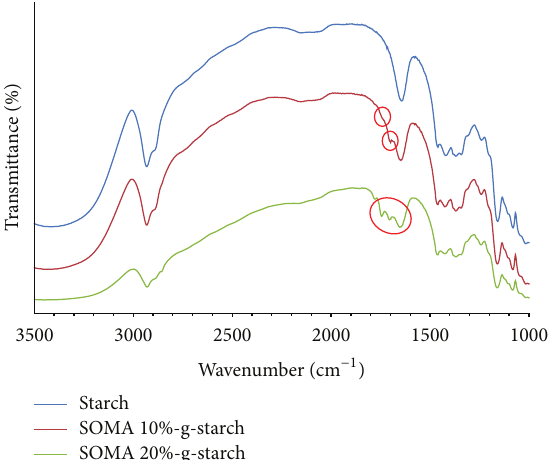
Figure 4: TGA thermograms of starch and soybean oil-g-cassava starch